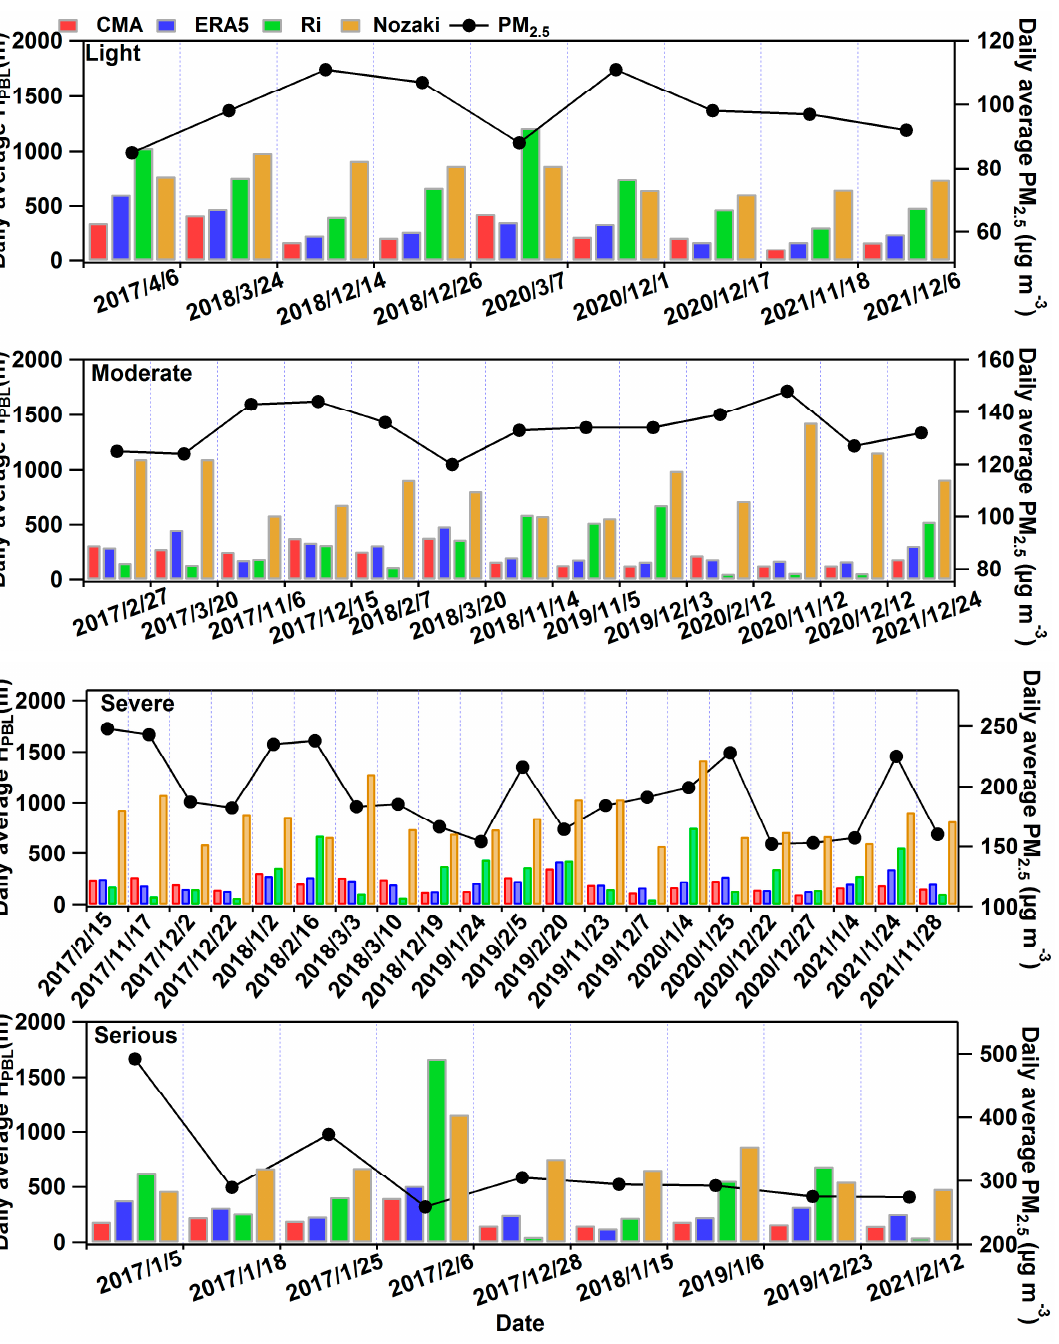
Figure 5. The histogram of different BLH values and the diagram of PM 2.5 concentrations in peak concentration days under different pollution processes. (CMA − BLH: red bar; ERA5-BLH: blue bar; Ri-BLH: geen bar; Nozaki − BLH: goldenrod bar; PM 2.5 concentration: dotted line).